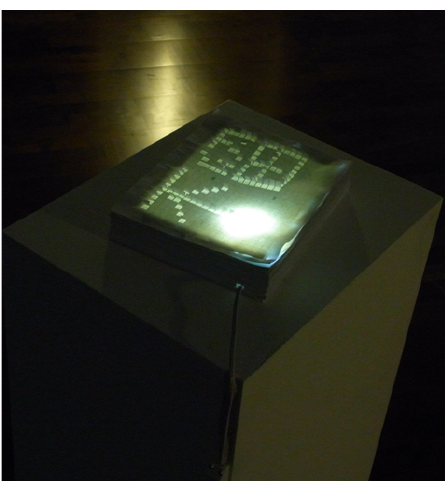
Figure 3: Dear teacher ,